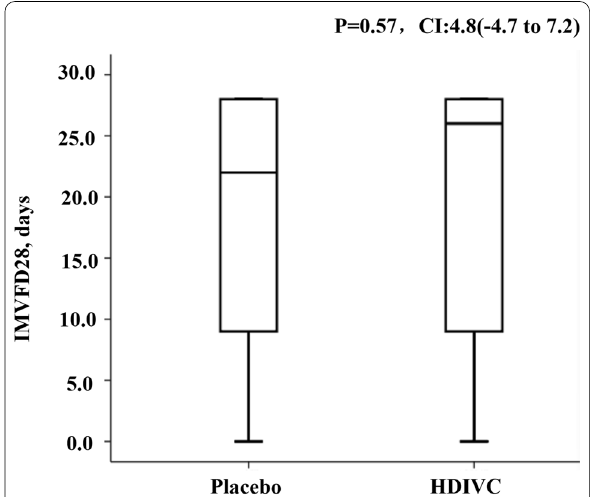
Fig. 2 The IMVFD28 in high-dose intravenous vitamin C and placebo group. The IMVFD28 was 26.0 days[9.0–28.0] in HDIVC, and 22.0 days[8.5–28.0] in placebo group, but this difference was not statistically significant ( P 0.57, CI 4.8[-4.7 to 7.2]). IMV invasive = mechanical ventilation, HDIVC high-dose intravenous vitamin